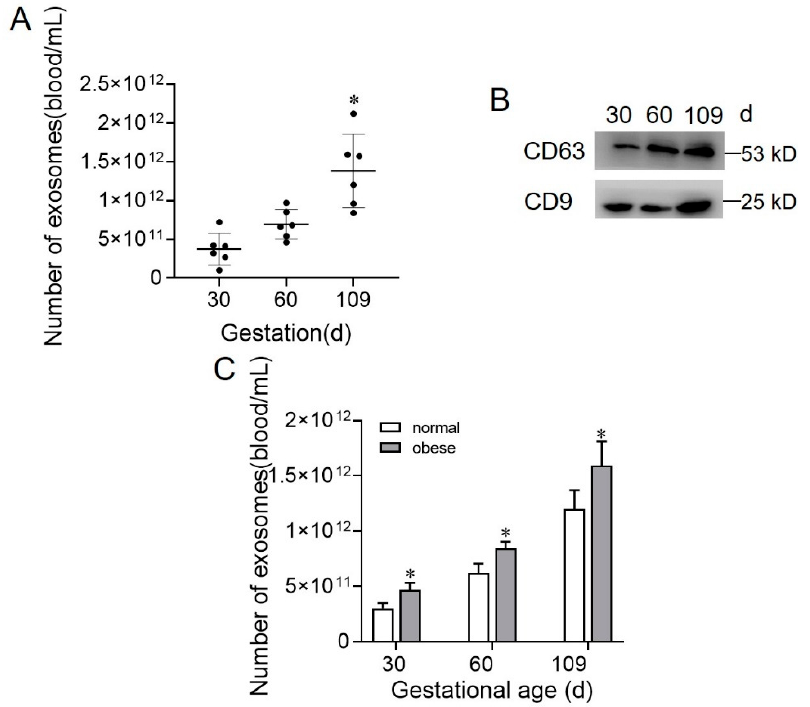
Figure 2. The level of plasma-derived exosomes of sows at different gestation stages and body conditions. ( A ) Total exosome number presented as the average across early (at 30 d of gestation), mid (at 60 d of gestation), and late gestation (at 109 d of gestation). ( B ) The expression of exosomal markers CD63 and CD9 at 30 d, 60 d, 90 d, and 109 d of gestation. ( C ) Total exosome number in normal (white columns) or obese (gray columns) at different gestation stages. Values are means ± SD. Values are means ± SD (n = 6). * p < 0.05.